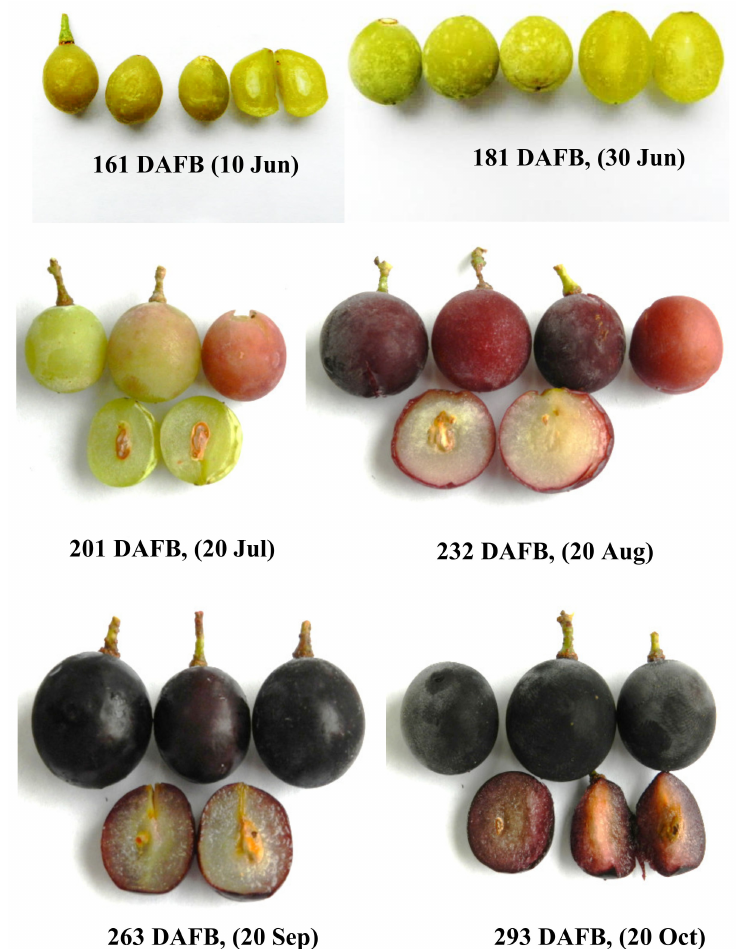
Figure 4. Berries of black ‘Isabel’ grape during six development stages. Scale bar = 0.5